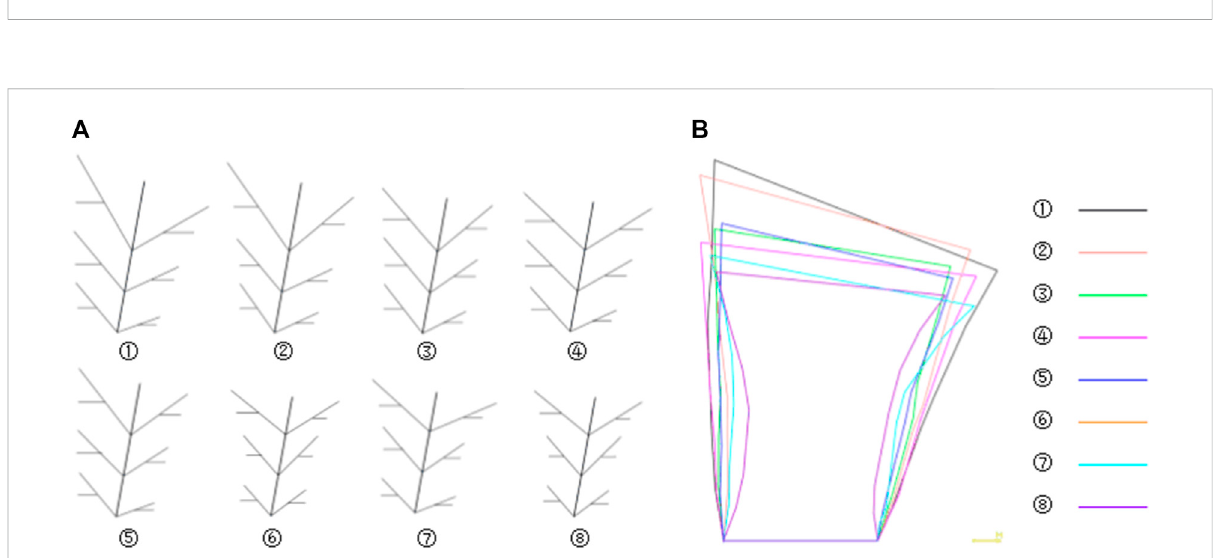
FIGURE 14 Bionic vein structures and sketches of femoral stem prosthesis. (A) Bionic vein structures generated by setting different semantic parameters shown in Table 2. These structures are numbered 1 through 7. (B) Feature sketches of the structures in panel (A) .